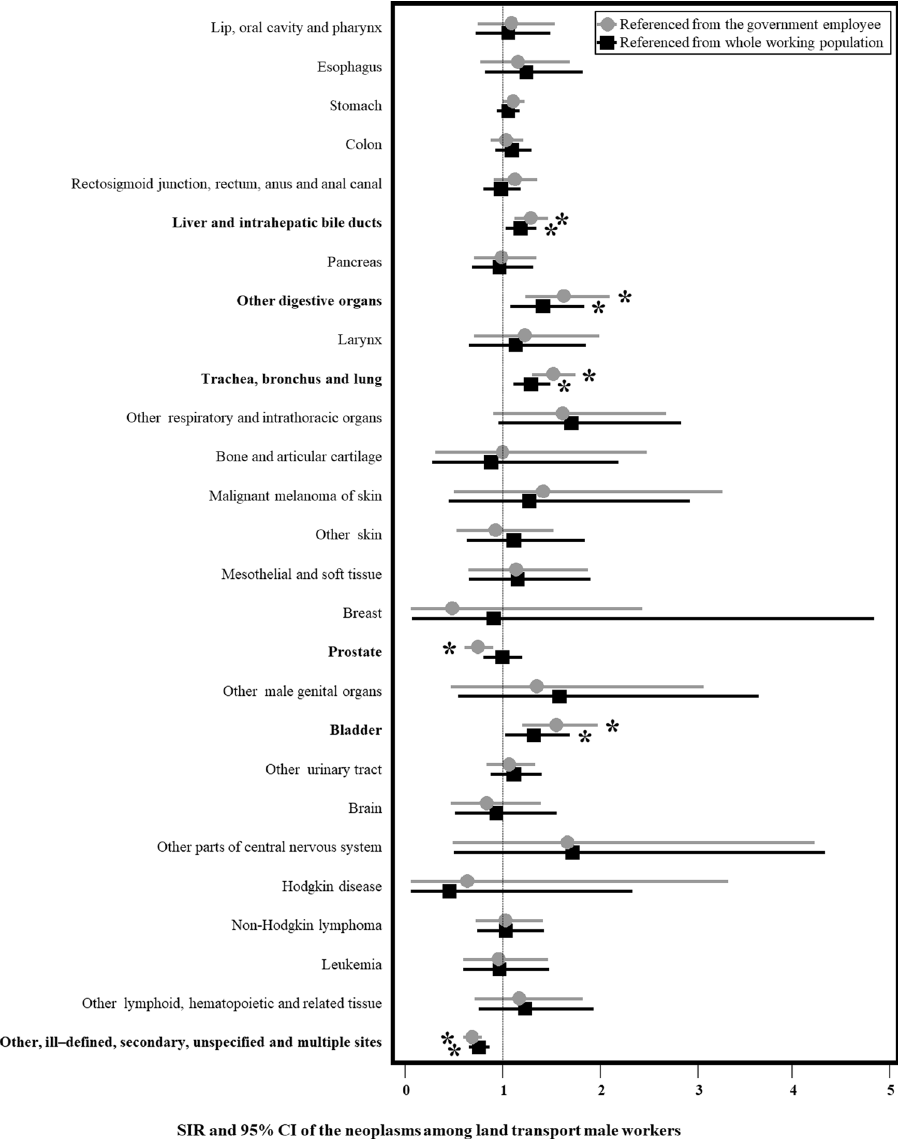
Figure 1. Standardised incidence ratio with 95% confidence intervals among land transport male workers reference from government employee and whole working population. This figure was drawn by author of